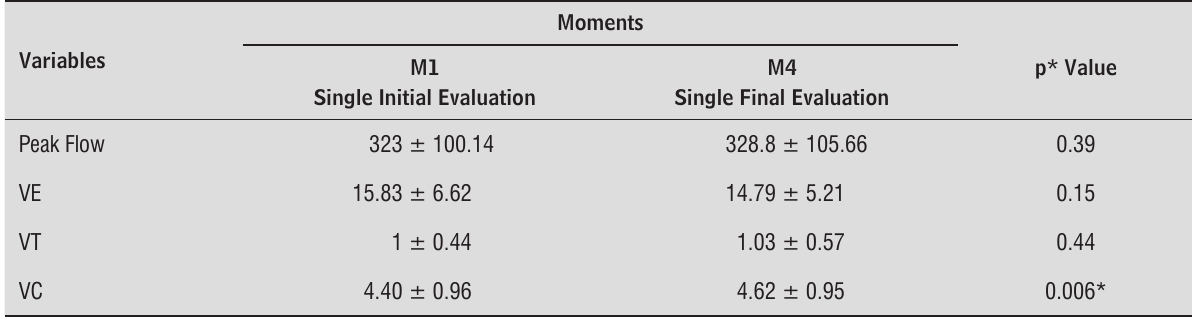
Table 3 - Comparison of cardiorespiratory variables achieved by a single evaluation between M1 and M4.